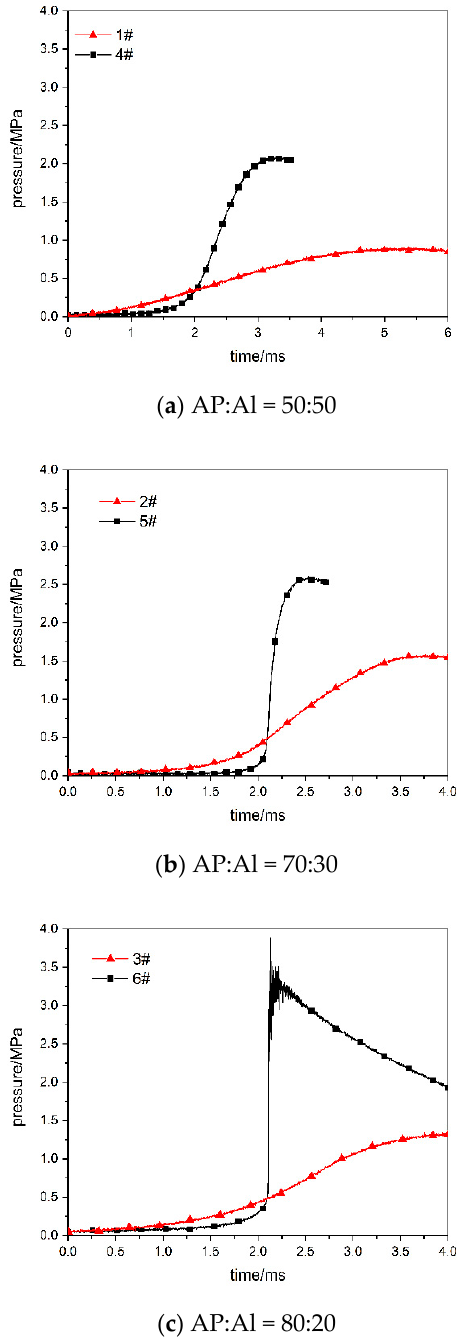
Figure 11. P–t curve for different AP:Al proportions. Table 4. Combustion characteristics of the AP-Al closed bomb for different AP:Al